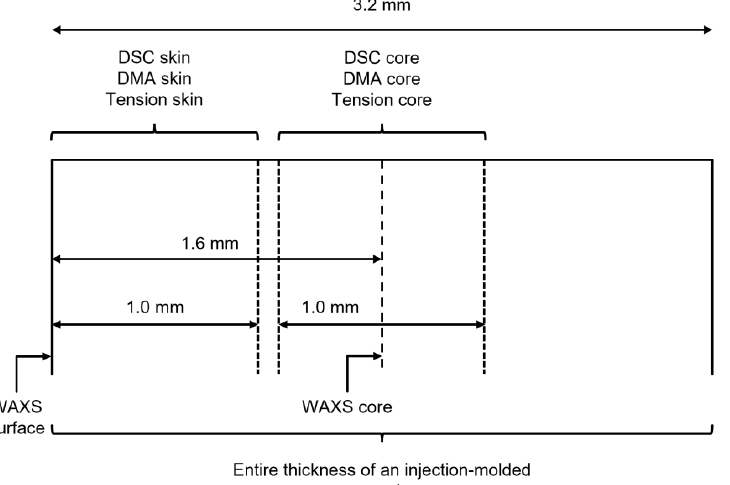
Figure 1. Illustration of the skin-core sampling strategy. The core and the skin samples were tooled from the whole thickness of the plates with a milling